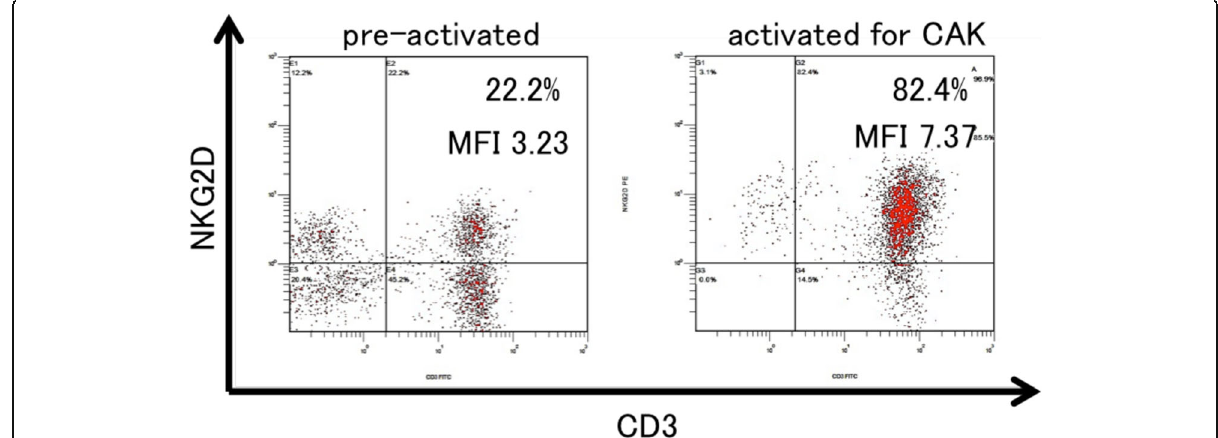
Fig. 4 Representative histogram of natural-killer group 2, member D (NKG2D) expression on lymphocytes, before and after stimulation. NKG2D expression levels on lymphocytes before and after activation were analyzed by fluorescence-activated cell sorting. Activation notably increased NKG2D expression on CAK cells